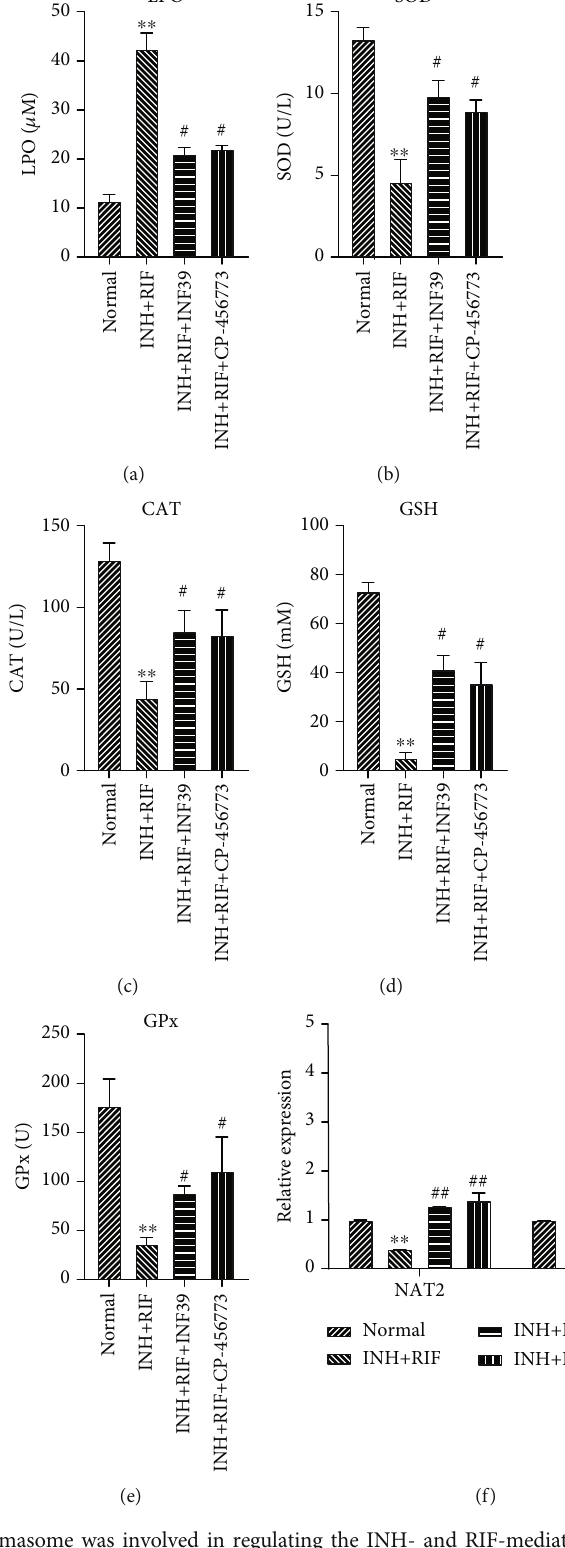
Figure 4: The NLRP3 in fl ammasome was involved in regulating the INH- and RIF-mediated OS-antioxidant defense system and drug- metabolizing enzymes in rats. INF39 or CP-456773 was administered to the INH- and RIF-induced rats, respectively. (a – e) Speci fi c commercial kits were used to monitor the levels of LPO and antioxidant enzymes (SOD, CAT, GSH, and GPx). (f) NAT2 and CYP2E1 expression were detected by QRT-PCR assays. ∗∗ P < 0 : 01 vs. the normal group; # P < 0 : 05 and ## P < 0 : 01 vs. the INH and RIF